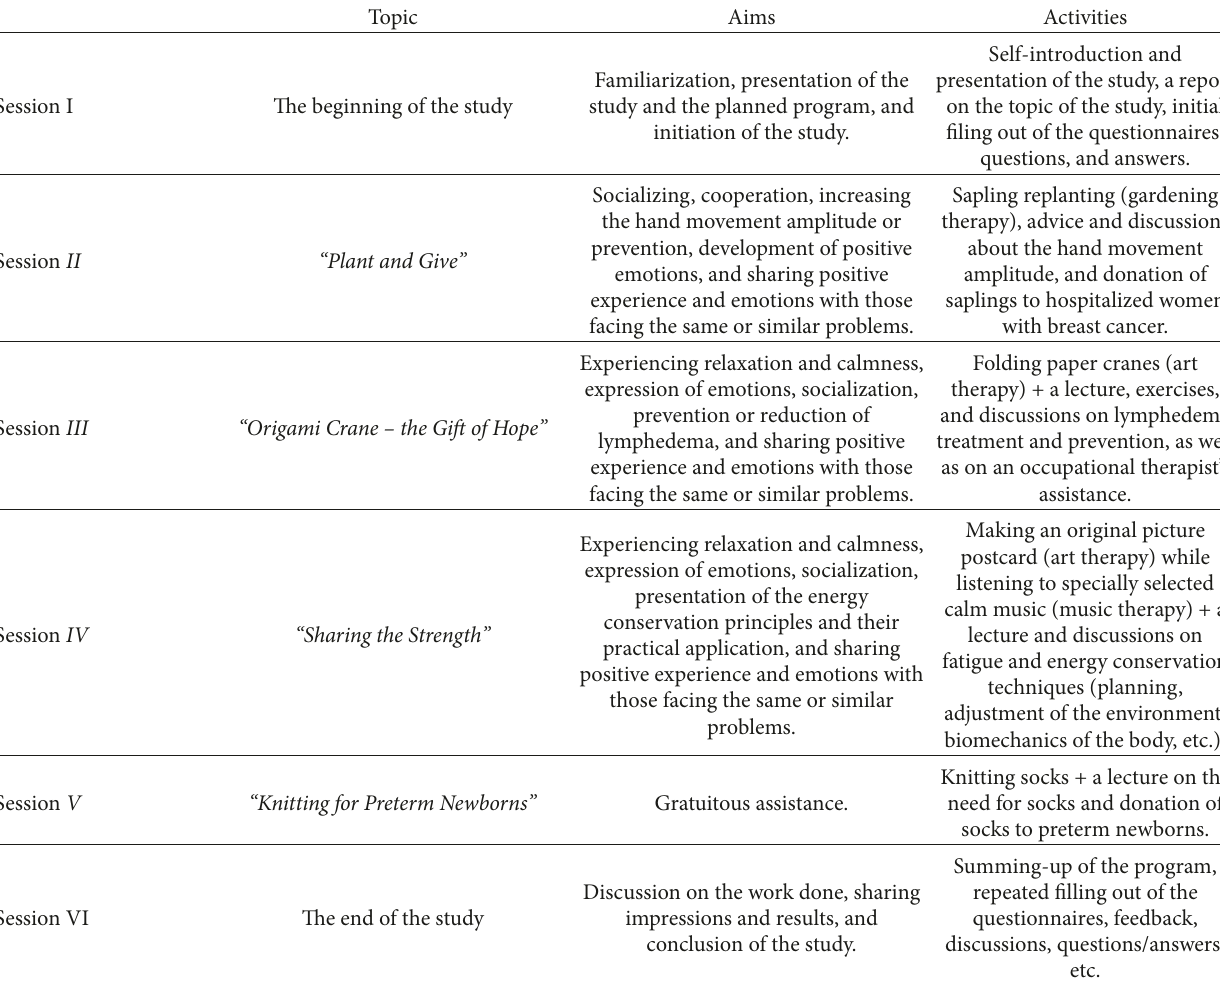
Table 2: Description of the application of the occupational therapy program in the community of women with breast